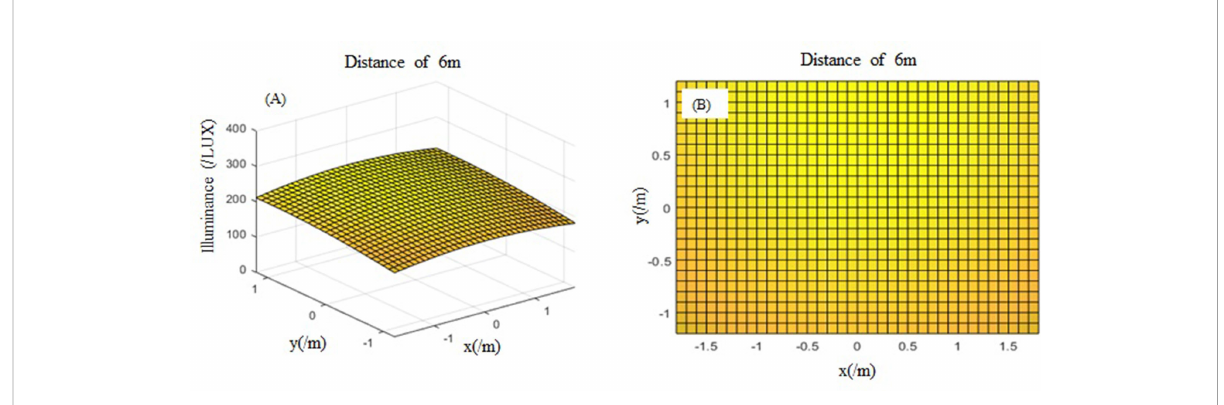
FIGURE 7 The illumination distribution of whole lighting system with a lighting distance of 6m. (A) the 3D view of illumination distribution; (B) the vertical view of illumination